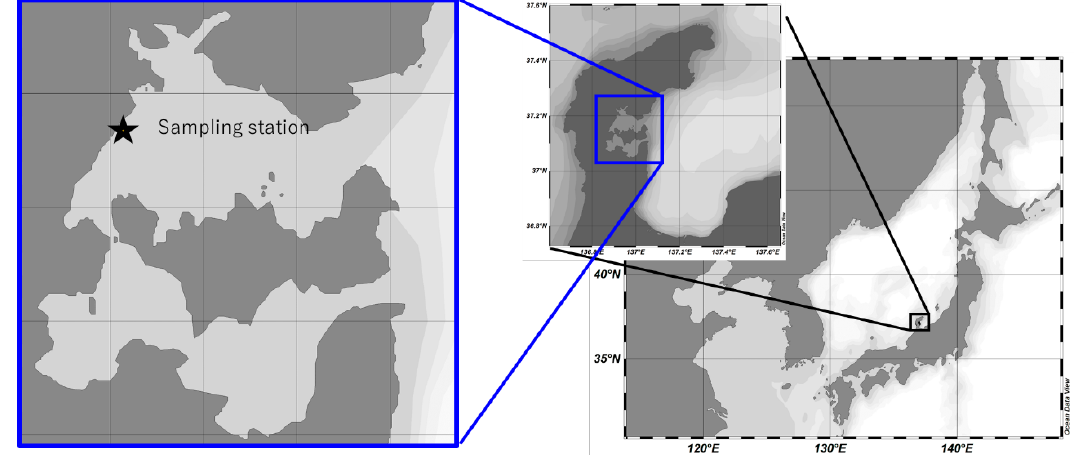
Figure 1. Sampling point at Noto Peninsula, Ishikawa Prefecture. July 2015–December